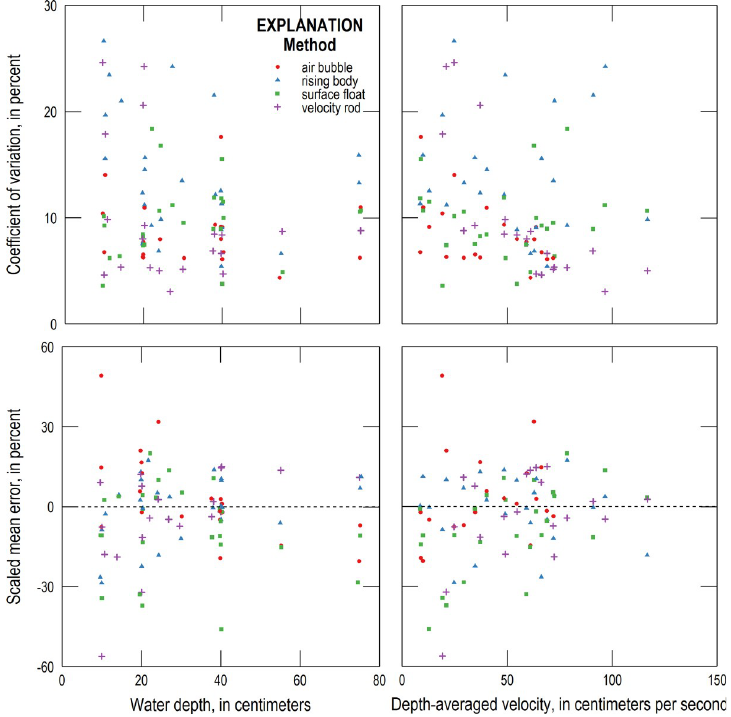
Fig 4. COV and SME versus water depth and depth-averaged velocity for each alternative velocity method.